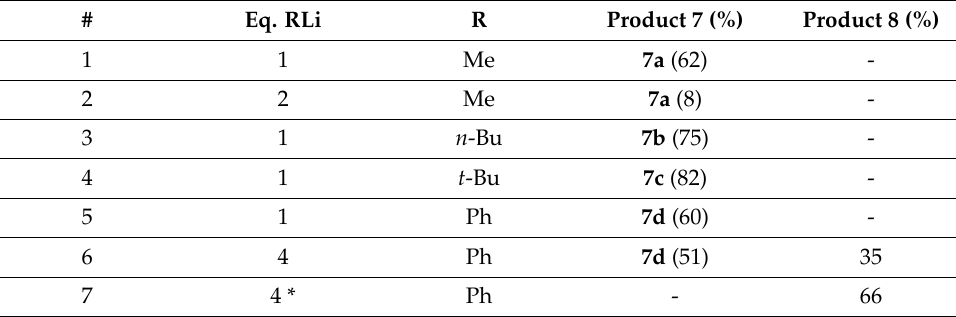
Table 4. Reaction conditions and yields of compounds 7a–d and 8